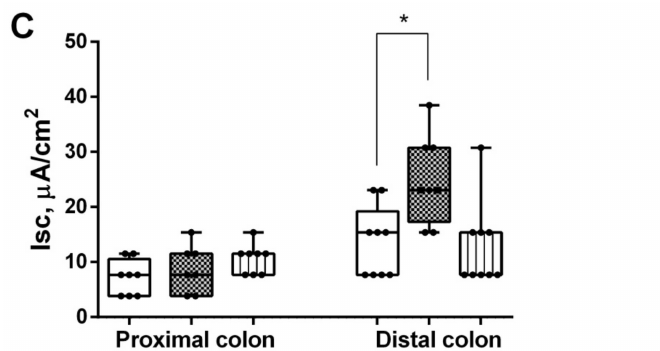
Figure 2. ( A ) Paracellular permeability for sodium fluorescein (P), ( B ) TEER, ( C ) Isc of the proximal and distal segments of the rat colon under the action of TNF α and IL10, * p < 0.05, ** p < 0.01,